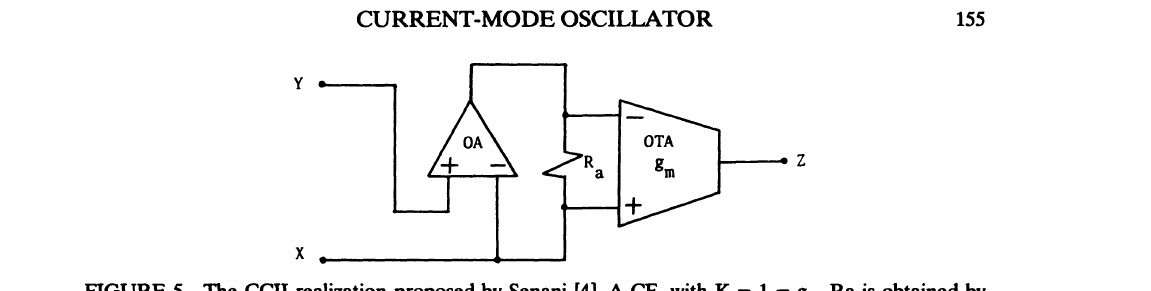
. FIGURE 5 The CCII-realization proposed by Senani [4]. A CF- with K 1 g. Ra is obtained by grounding terminal